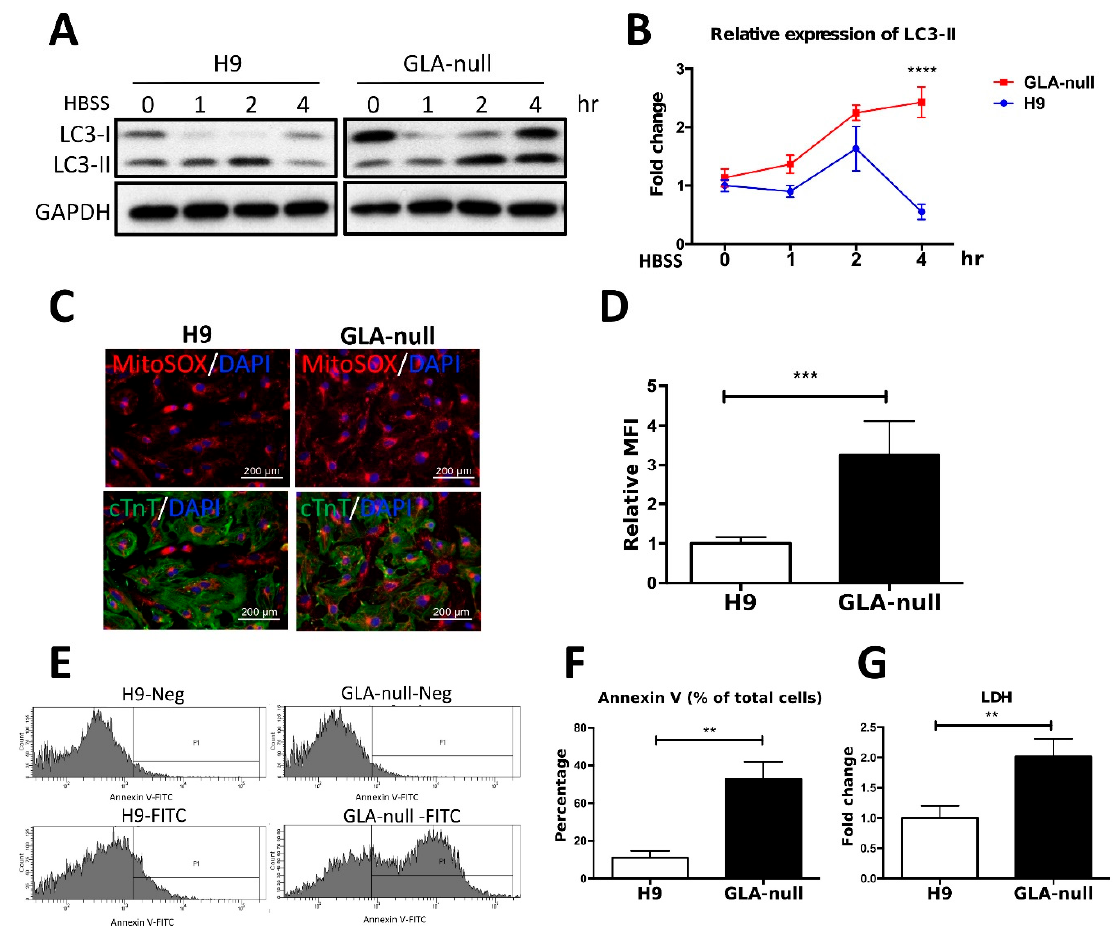
Figure 5. Vesicle turnover impairment induces cardiotoxicity in GLA-null CMs. ( A ) Western blot showing expression of LC3 protein isoforms (LC3-I and LC3-II) in a time course of induction of autophagy with HBSS medium. GAPDH was used as a loading control. ( B ) The expression levels of LC3-II were measured by using ImageJ and the quantification results presented as mean ± standard deviation error bars from three independent experiments. ( C ) Staining of mitochondrial ROS in GLA-null CMs and H9 control CMs with MitoSOX Red. ( D ) MitoSOX Red fluorescence intensity quantified by flow cytometry presented as mean ± standard deviation from three independent experiments. ( E ) Flow cytometry analysis of annexin V-positive cells in populations of GLA-null and H9 CMs. ( F ) Quantitation of annexin V-positive cells. ( G ) The level of LDH secreted by H9 and GLA-null CMs. The data are presented as a fold change relative to H9 control. These data are presented as mean ± standard deviation error bars from three independent experiments.